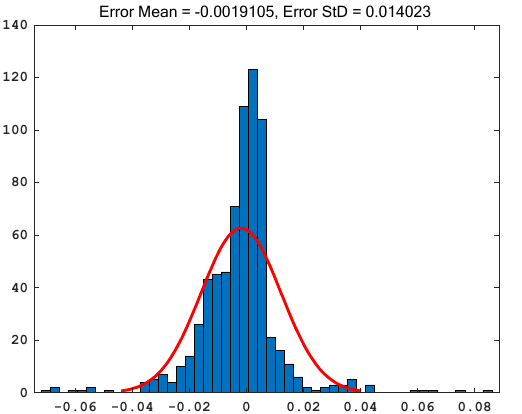
Figure 11. Error mean and error standard deviation for the training data for the following parameters: nMax = 16, maxL = 6, α = 0.5, m = 5, and pTrain = 70%.